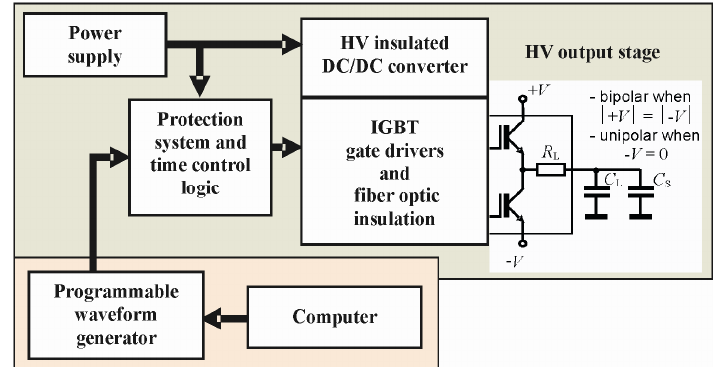
Figure 18. Block diagram of IGBT modules-based pulse voltage generator (6 kV/ ± 3 kV).